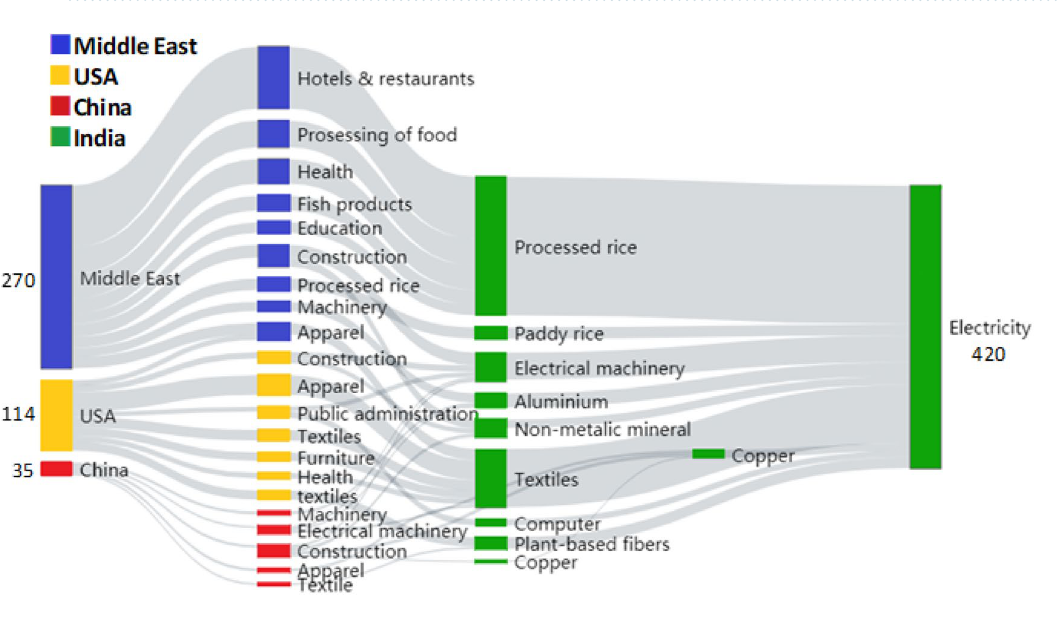
Figure 4. Top 10 supply chain paths ranked in terms of health impact driven by the Middle East, USA, China in the second to fourth (IND) → Electricity (IND), which also has a high health impact, inducing 110 premature deaths. The USA imports textiles produced in India, and the textiles sector in India induces a health impact in India via electric- ity consumption. We therefore posit that the USA should also be involved in mitigation measures related to imports of Indian textiles. Figure 4 is a Sankey Diagram showing the top 10 supply chain paths in tiers 2 to 4 that are driven by final demand sectors in the Middle East, the USA, and China (Total 30 paths). The figure shows that there are high- ranking paths centered on imports of processed rice in India via food processing and service sectors in the Middle East: Middle East → Hotels and Restaurants (Middle East) → Processed rice (IND) → Electricity (IND) (80 premature deaths); Middle East → Processing of food (Middle East) → Processed rice (IND) → Electric- ity (IND) (38 premature deaths); and Middle East → Health and social works (Middle East) → Electricity (IND) (35 premature deaths). The textile supply chains linking India with the USA also have a high health impact: USA → Apparel (USA) → Textiles (IND) → Electricity (IND) (28 premature deaths); USA → Textiles